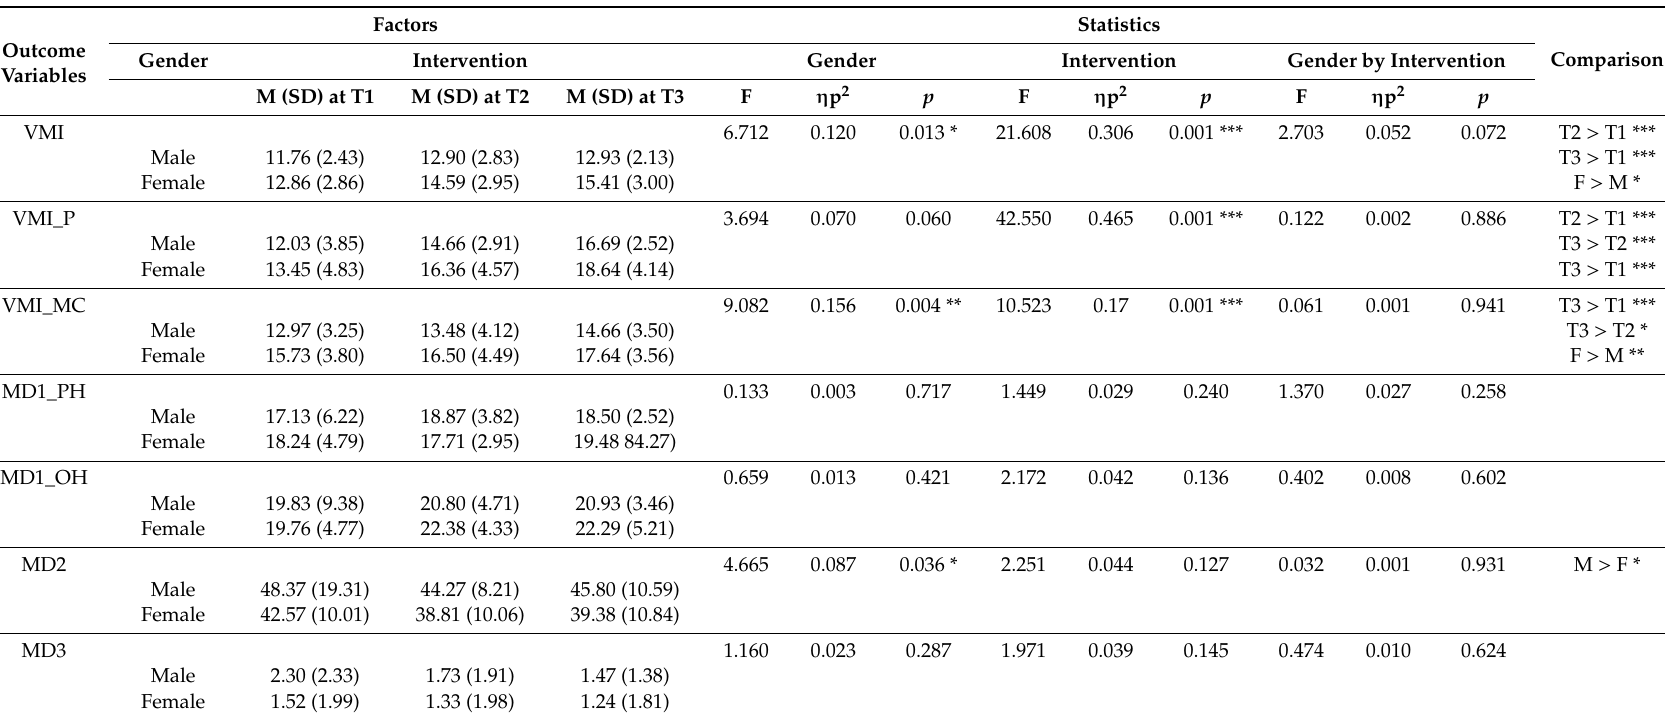
Table 7. Means and SD for the main outcome variables and partial eta-squared values associated with gender and time-intervention factors. Factors Outcome Variables